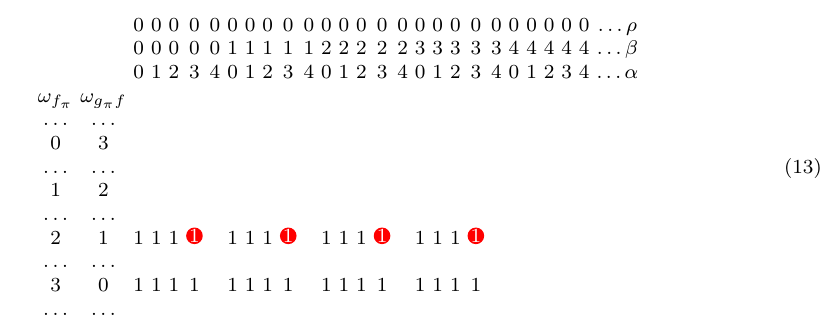
Figure 13: The vulnerability profile of the robust-3-probing secure CMS scheme found with our formalization. This has been computed only for a sum of the hamming weight of the output spectral coordinates (i.e., the sum of probes) equal to 3. Red circles indicate where the vulnerability profile fails to be robust-3-SNI because for ω f = 2 there can be a dependency with up to α = 2 π or β =